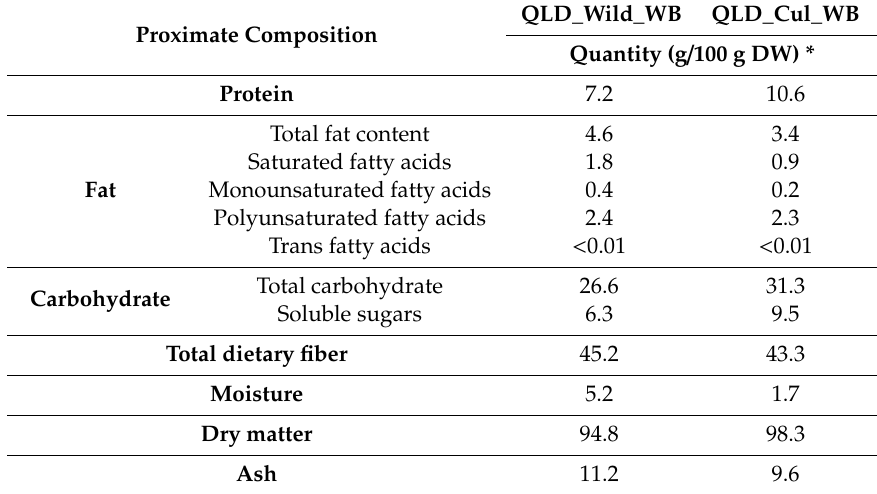
Table 1. Proximate composition of P. angustifolium whole branch samples collected in